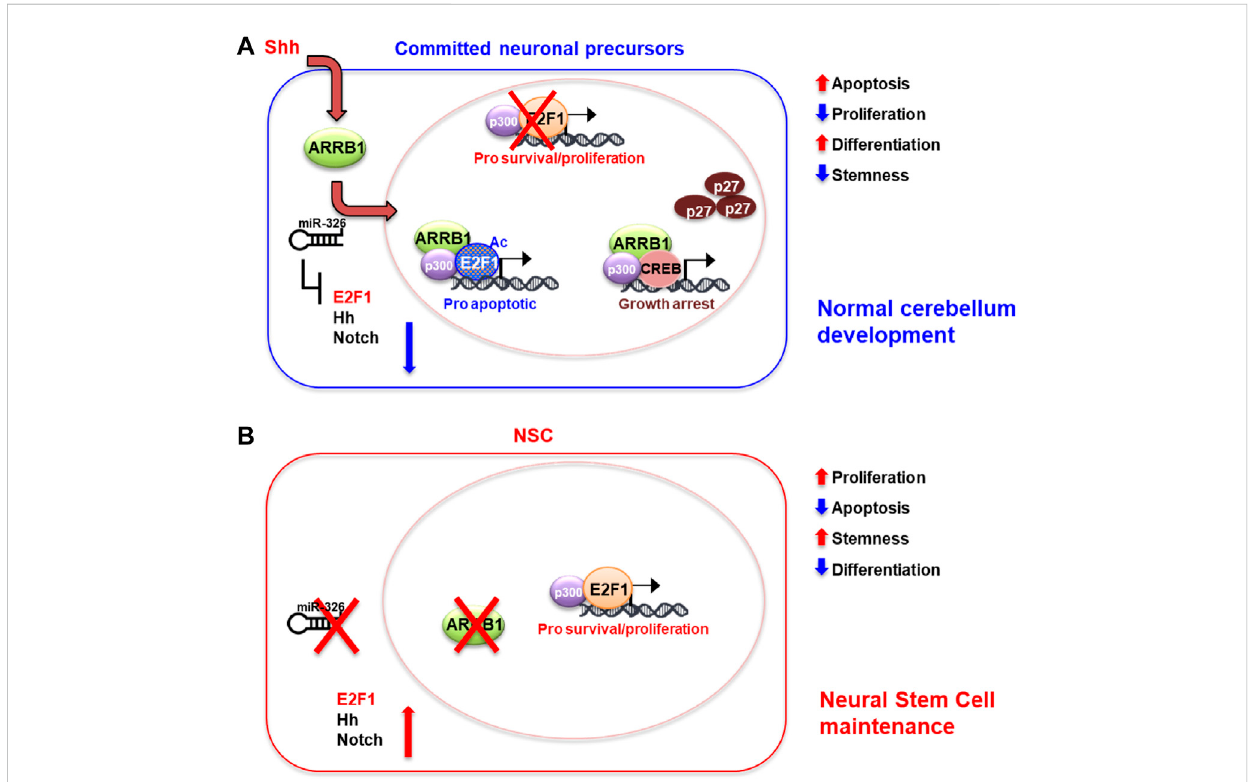
FIGURE 5 Schematic model of ARRB1/E2F1-ac functions in GCPs and NSCs. Overview of roles played by ARRB1/E2F1-ac in normal cerebellar development. (A) :Committed neuronal precursors (i.e., NSCs grown in DFM, GCPs). In our previous works, we identi fi ed miR-326 as amiRNA necessary for maturation ofgranule cell progenitors(GCPs)into mature granule cells (Ferrettietal., 2008).Moreover,thismiRNA isintegrated into the fi rst intronof the Arrb1 gene and shares the same regulatory regions as its host gene. miR-326 also contributes to ARRB1 functions by blunting proliferative signals mediated by E2F1, Hedgehog, and Notch, and by promoting cell differentiation (Ferretti et al., 2008; Kefas et al., 2009; Po et al., 2017; Miele et al., 2021). Committed neuronal precursors express ARRB1 and mir-326, which regulate their development at multiple levels. Shh signaling upregulates ARRB1 levels and promotesitstranslocationtothenucleus.ThereARRB1,incomplexwithP300,inducesacetylationofE2F1(E2F1-ac),redirectingthetranscriptionfactors activity from survival/proliferative gene targets towards those that promote apoptosis ( Trp73, Caspases 3 and 7 ). Interacting with CREB and P300, ARRB1 upregulates the expression and nuclear accumulation of P27, which eventually blocks cell cycle progression. miR-326 favors neuronal cell differentiations by inhibiting multiple survival/proliferative signaling: E2F1, Hedgehog (Hh) and Notch via direct binding of the 3 ′ -UTRs of E2f1, Smo, Gli2, Notch1 and Notch2 . (B) : In NSCs, non-expression of ARRB1 and miR-326 promotes cell proliferation, survival, and stemness by favoring non-acetylated E2F1 activity and active Hedgehog (Hh) and Notch